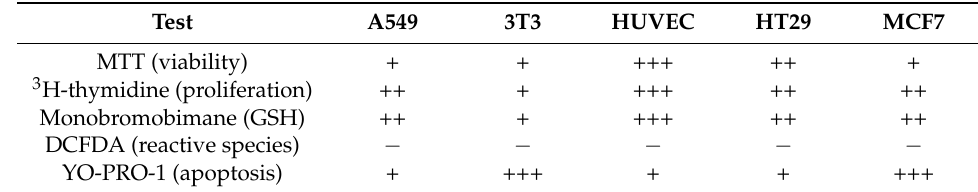
Table 1. A comparison between the various cell lines tested in their relative responses to allicin. + = low, ++ = intermediate, +++ = strong, − = no